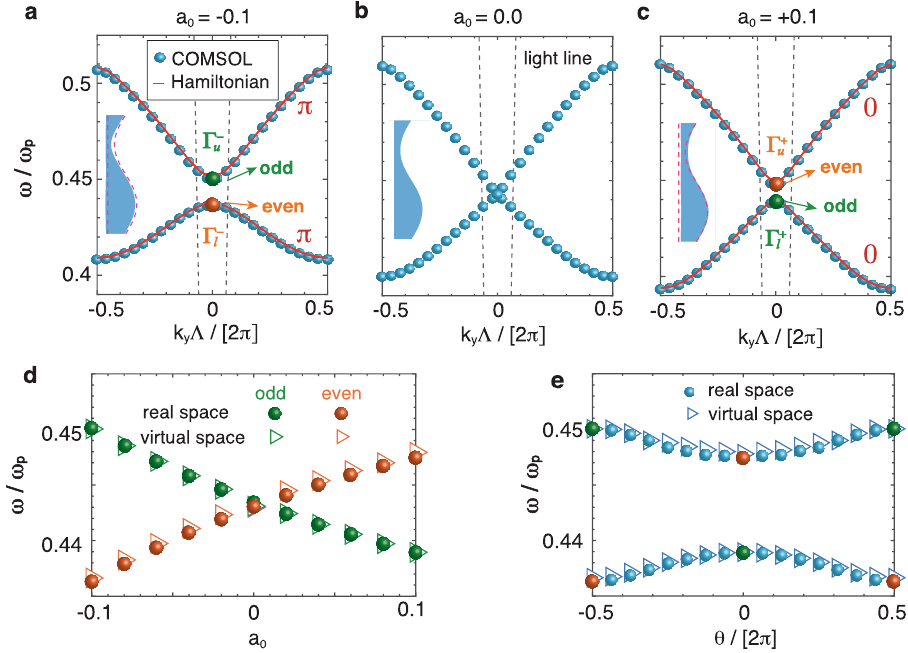
= δ exp(i θ ). The two solid 0